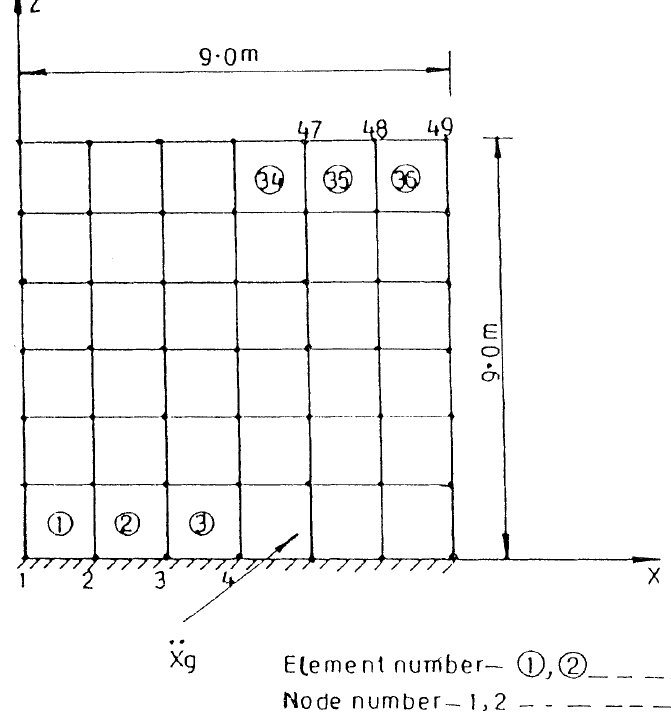
Fig. 2. Finite element model of the plate fixed at ground subjected to earthquake loading transverse to the plane of the